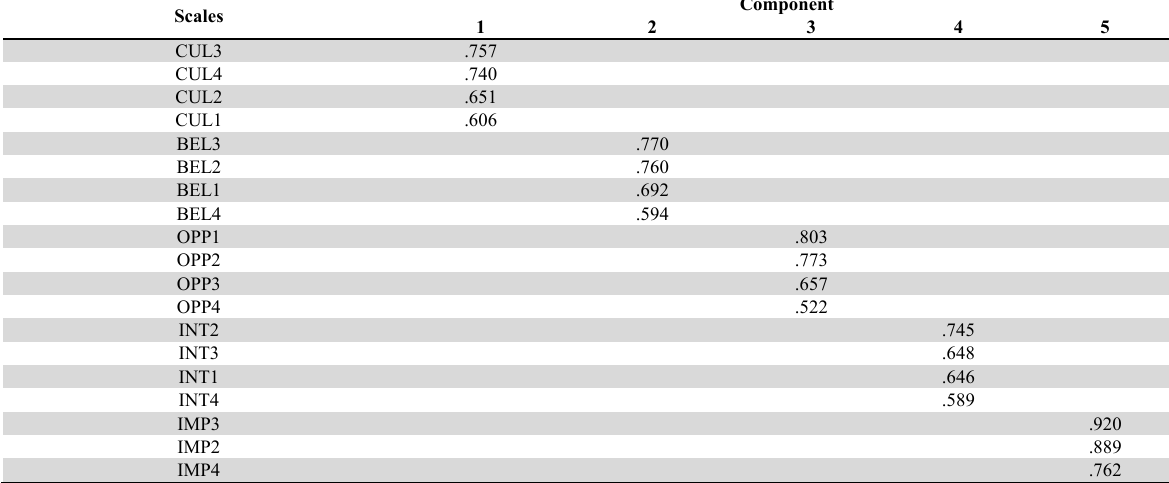
Rotated Component Matrix